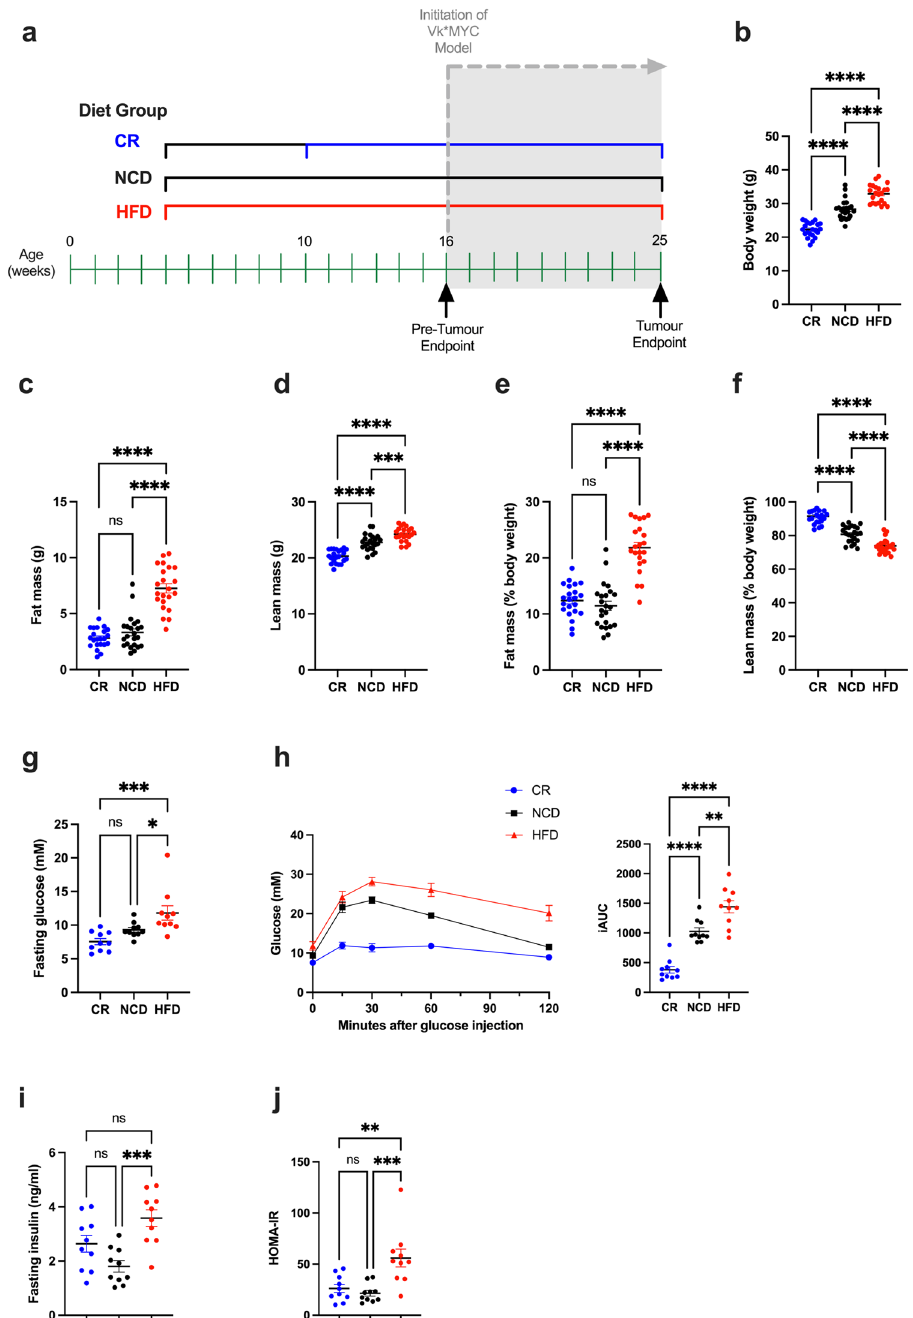
Figure 1. Effects of dietary regimens on body weight, composition and glucose tolerance at pre-tumour endpoint. ( a ) Experimental timeline showing duration of diets and analysis endpoints, ( b ) Body weight, ( c ) Fat mass, ( d ) Lean mass, ( e ) Fat mass (% body weight), ( f ) Lean mass (% body weight), ( g ) Fasting blood glucose levels, ( h ) Glucose clearance over time, ( i ) Fasting insulin levels, ( j ) HOMA-IR scores. Error bars SEM, ( b – f ) data n = 22–23/group, ( g – k ) data n = 10/group, ns p > 0.05, *p < 0.05, **p < 0.01, ***p < 0.001, ****p < 0.0001, ordinary one-way ANOVA with Tukey’s multiple comparisons